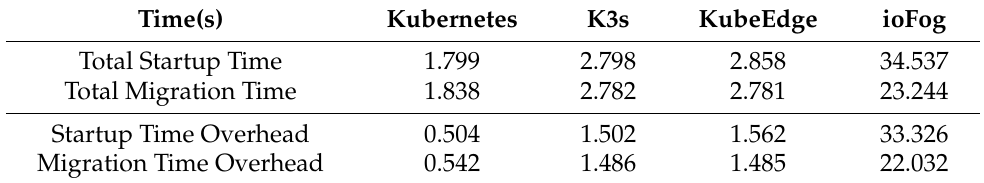
Table 4. Performance comparison